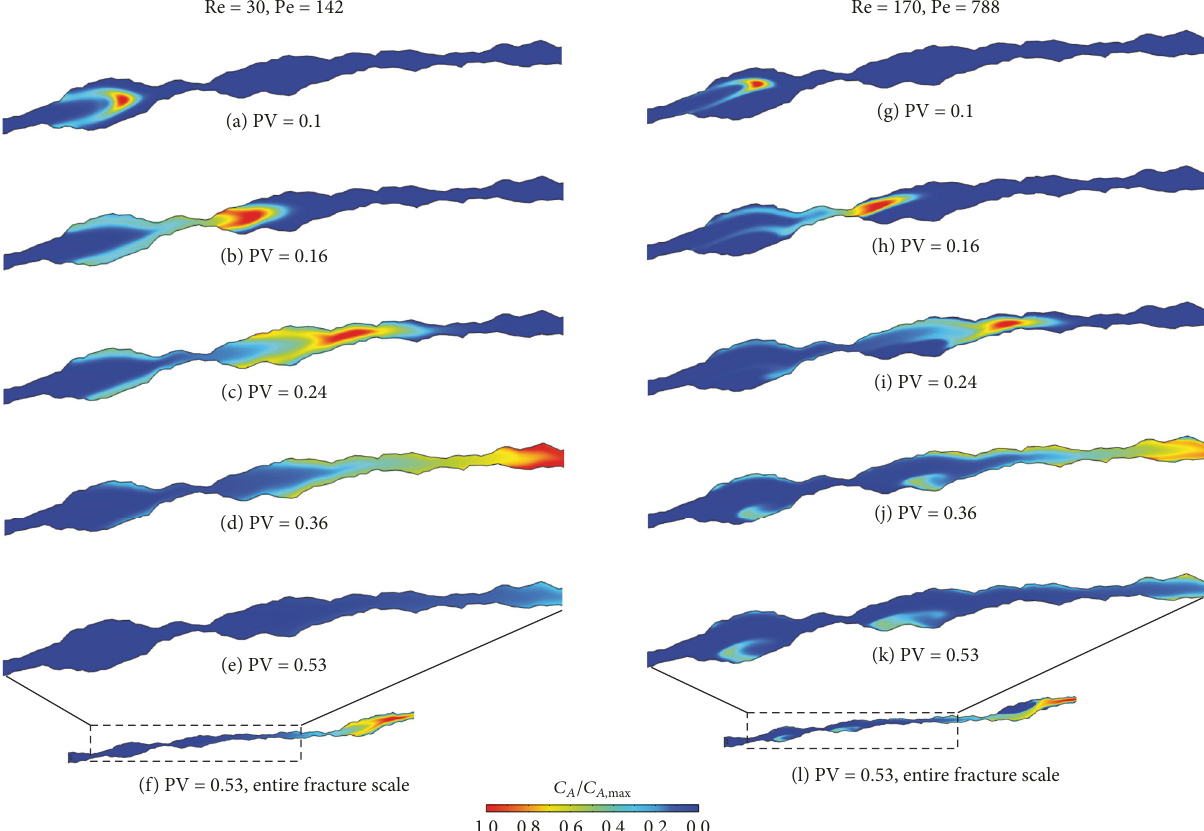
Figure 4: Nonreactive compound A transport through the self-affine fracture with Hurst exponent of 0.8 under in FF#1 and FF#4.